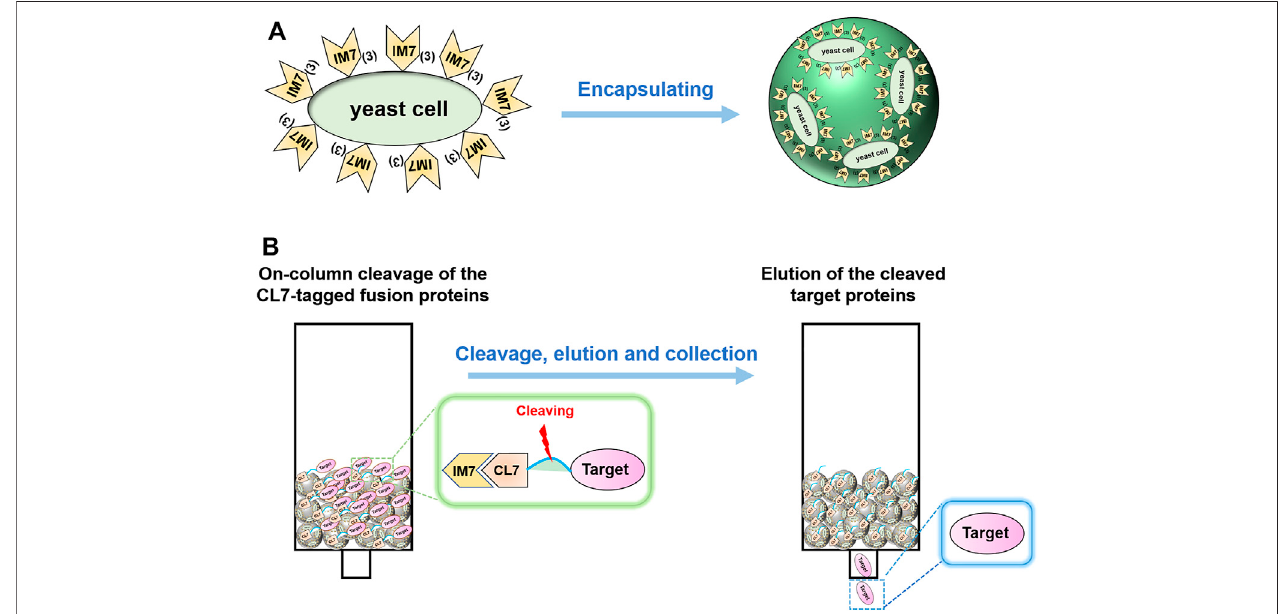
FIGURE 1 | (A) Schematics of encapsulating the IM7-displaying yeast cells by calcium alginate. (B) Flow diagram of one-step protein puri fi cation by using the Ca- alginate yeast-encapsulated